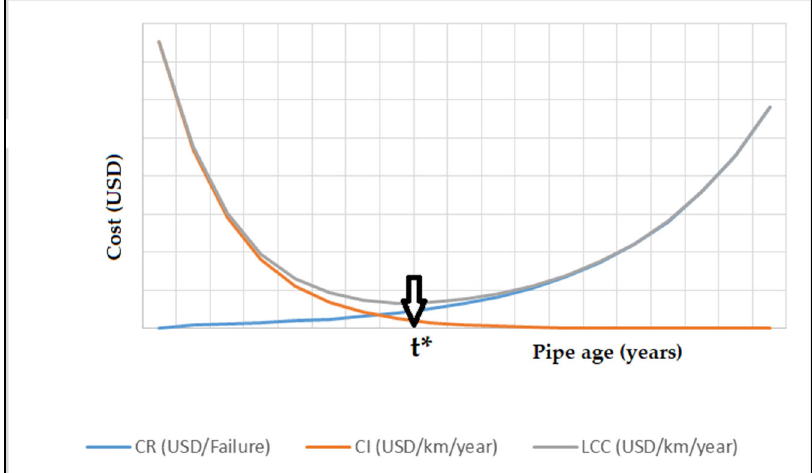
Figure 1. Illustration of LCC curve for obtaining the optimum pipe renewal time.